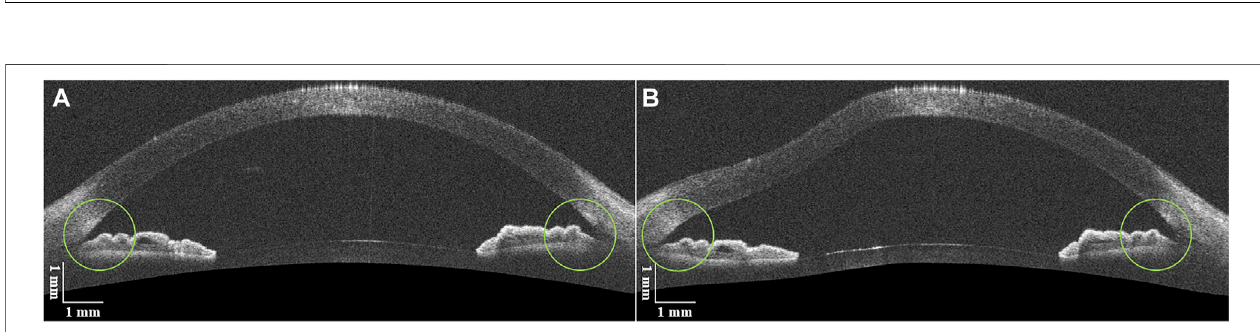
FIGURE 3 | Bland – Altman plots of the repeatability of ACA parameters. (A) , AOD750; (B) , TISA750. Each subject was labeled by different shapes of spots. Black spots, parameters before the air puff; red spots, parameters after the air puff.